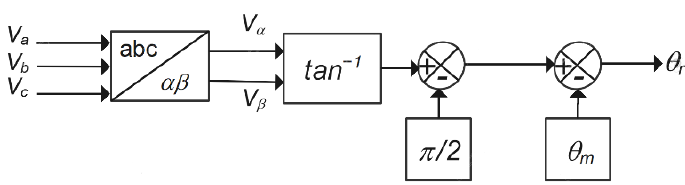
Figure 6. Angle calculation block diagram of the rotor-side converter.